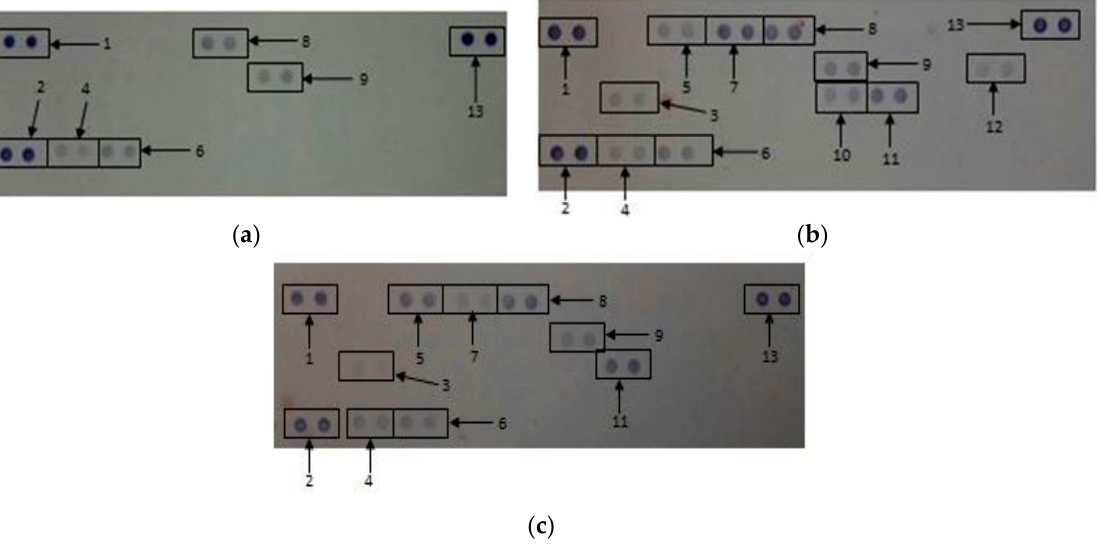
Figure 7. The effects of GONPs on whole blood cells. Cells were incubated with ( a ) media only, ( b ) media and LPS, ( c ) 5 μ g/mL GONPs in the absence of LPS. Cytokines/chemokines that were detected were allocated numbers: 1, 2 and 13 are reference spots; 3-IL-1ra; 4-MIF; 5-MCP-1; 6-Serpin E1; 7-MIP-1 α / β ; 8-RANTES; 9-ICAM-1, 10-IL-6, 11-IL-8 and 12-IL-1 β